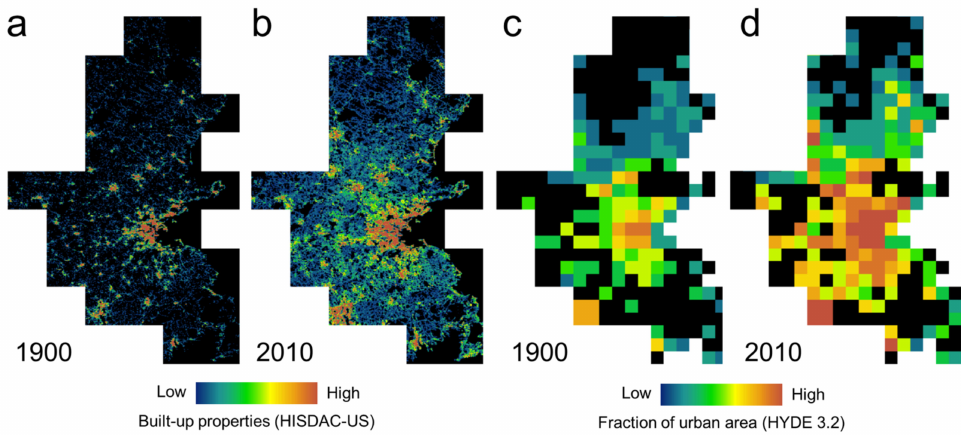
Figure 4. Evaluation data. Historical settlement data compilation for the US (HISDAC-US) built-up properties (BUPR) for ( a ) 1900 and ( b ) 2010, and urban area fractions per grid cell from the history database of the global environment (HYDE 3.2) for ( c ) 1900 and ( d ) 2010, all shown for the Boston metropolitan